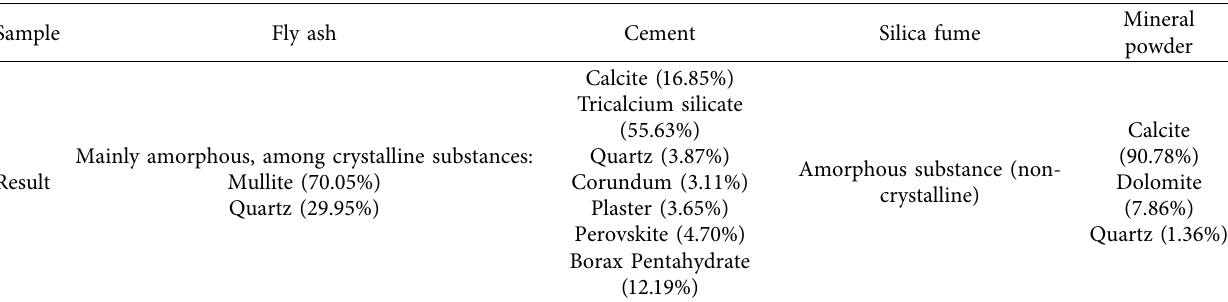
Figure 7: XRD calibration results of 4 kinds of cementitious materials (a) XRD calibration results of fly ash (b) XRD calibration results of Table 4: XRD test calibration results.